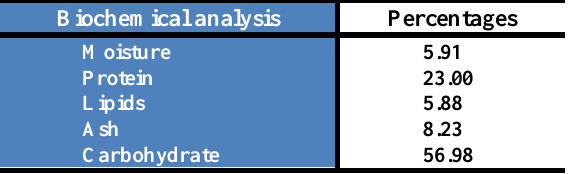
Table, 1: Percentages of biochemical analysis of local commercial fish diet.